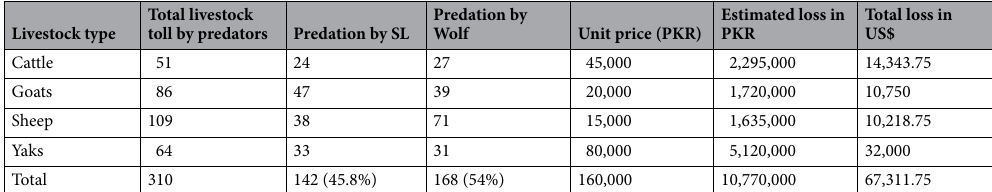
Table 1. Economic cost of predation by snow leopard and wolf in Misgar valley, district Hunza, during years 2014–2019. Average estimated price for predated livestock established village conservation scheme,